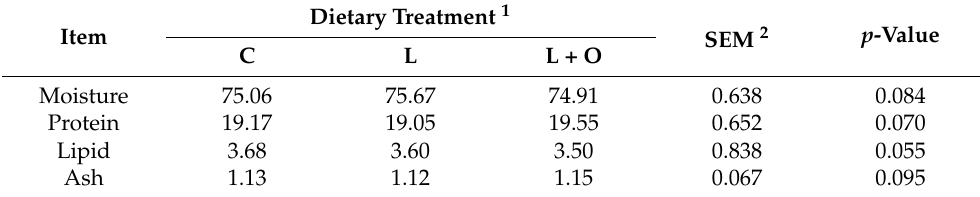
Table 8. Chemical composition (%) from Longissimus lumborum muscle